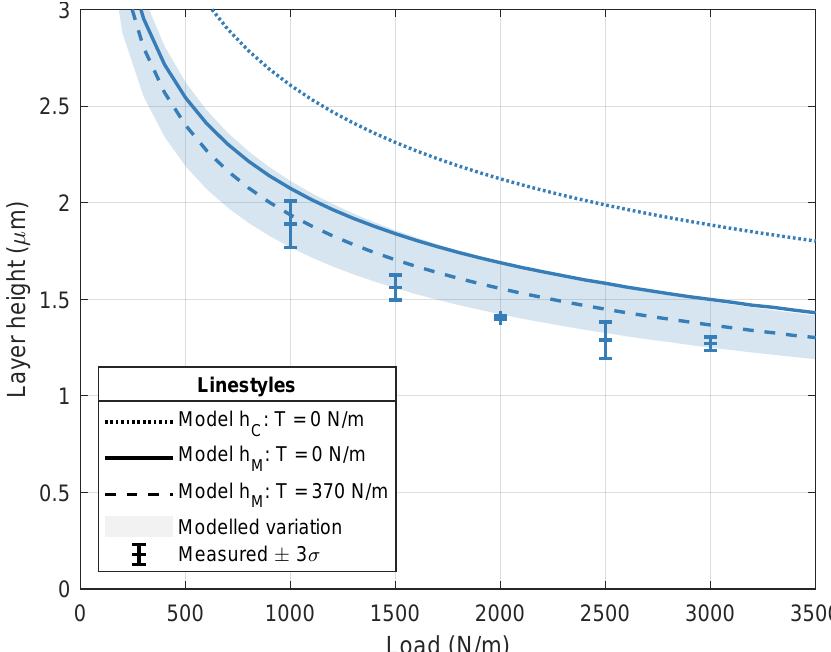
Figure 8. Numerical and experimental results for the layer height for a varying imprint load. The modeled results include a ± 10% variation in both elastic modulus of the elastomeric layer and resin viscosity. The simulations and imprints are performed with Resin B from Table 1 (viscosity of 38mPas) and a constant imprint velocity of 6.7mms − 1